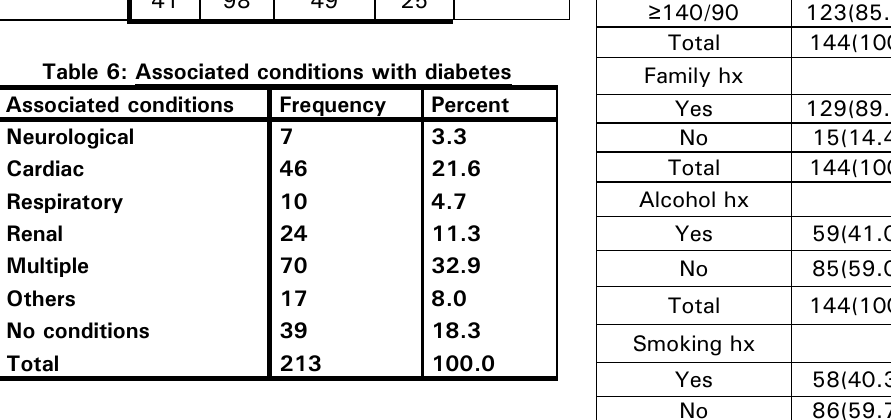
Table 7: Association of different factors with DR Sr